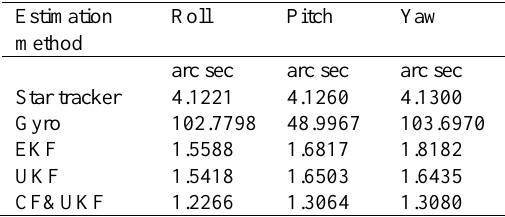
Table 1. Statistics of attitude estimation